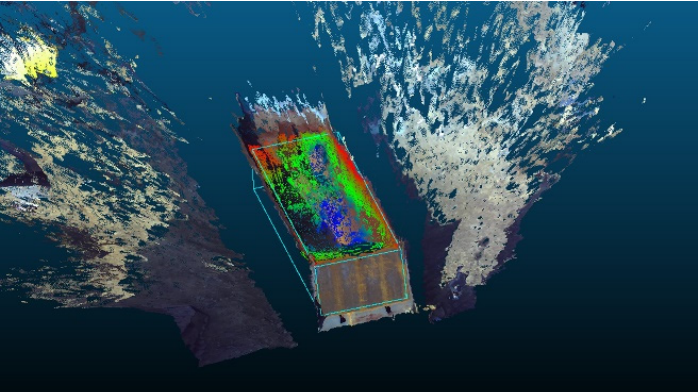
Figure 22. Visualization of the inside of the loader analysis. The excavator can load loads in areas other than the red area.